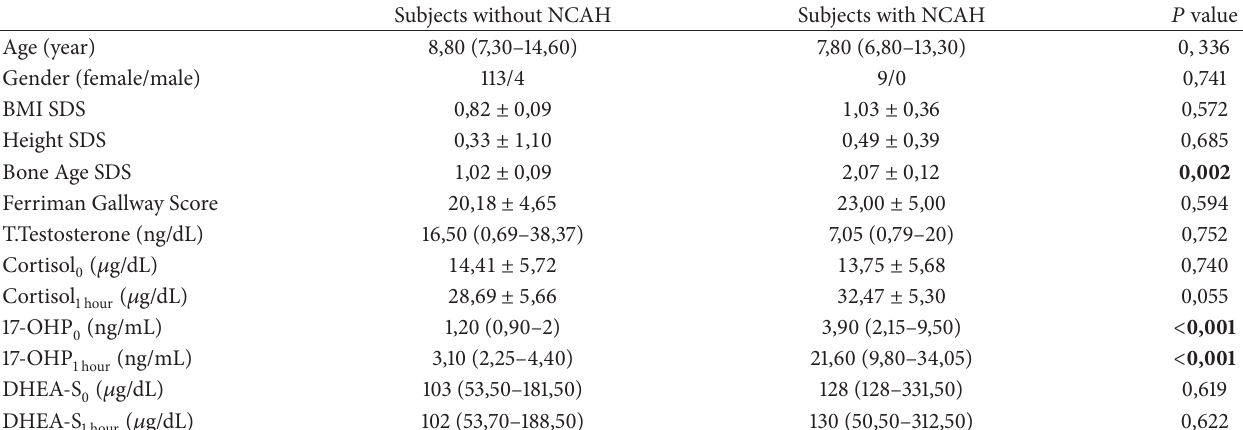
Table 1: Clinical characteristics and laboratory findings of study subjects.